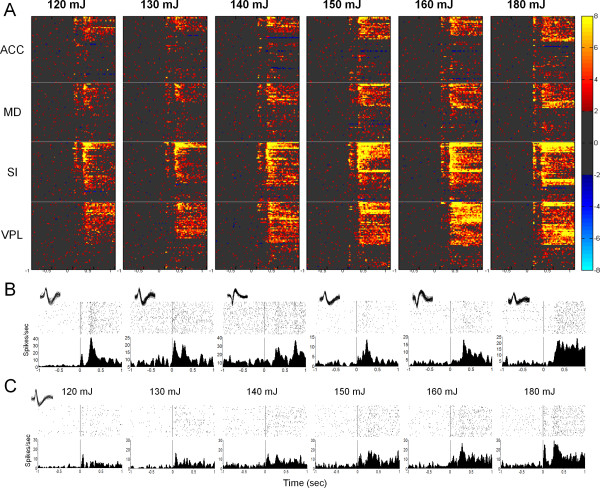
Neuronal responses in the medial (ACC, MD) and lateral (SI, VPL) pain pathways induced by laser stimulation. (A) Cluster plot depicting the temporal distribution patterns of neuronal activity in response to laser stimulation. The firing rates were transferred into Z-scores and neurons with Z-scores > 2 were accepted as significantly excited and < -2 as significantly inhibited. The colorbar legend ranges from light yellow for highest Z-score to light blue for lowest Z-score. Each line in the image represents the normalized activity of one neuron. (B) Raster and peri-event histograms showing various types of neuronal responses in the ACC, MD, SI, and VPL. Each dot in the raster (top) depicts the time of occurrence of a neuronal spike, with each row representing an individual trial. The peri-event histogram (bottom) illustrates the average firing rate of a neuron relative to the laser stimulation. Time = 0 on the x axis corresponds to the the laser stimulation onset. Insets show spike waveforms from each recording. (C) A representative example of an ACC neuron whose activity increased with stimulus intensity (120-180 mJ).